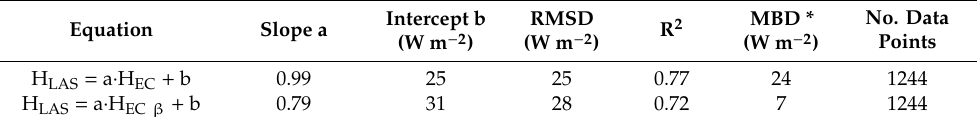
Table 1. Summary of sensible heat flux comparison and regression statistic.